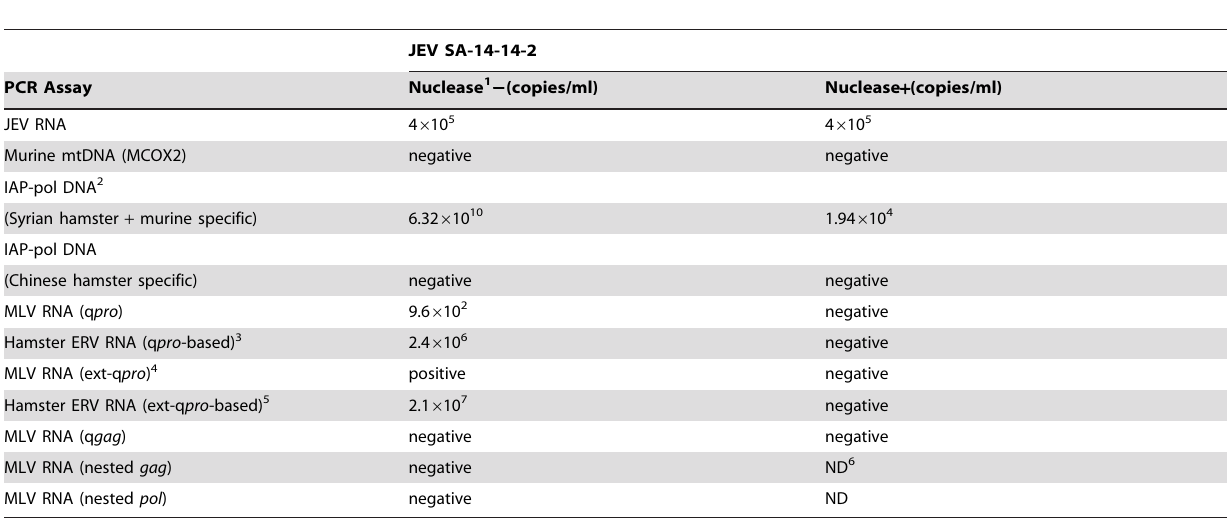
level of sequence divergence from the generic MLV probes used in the qPCR assay. Indeed, analysis of this 91-bp pro sequence identified a distinct gammaretrovirus that is equidistant from Table 2. Detection of Japanese encephalitis virus (JEV) RNA, hamster endogenous retrovirus (ERV) DNA, and hamster genomic DNA in the live, attenuated JEV vaccine